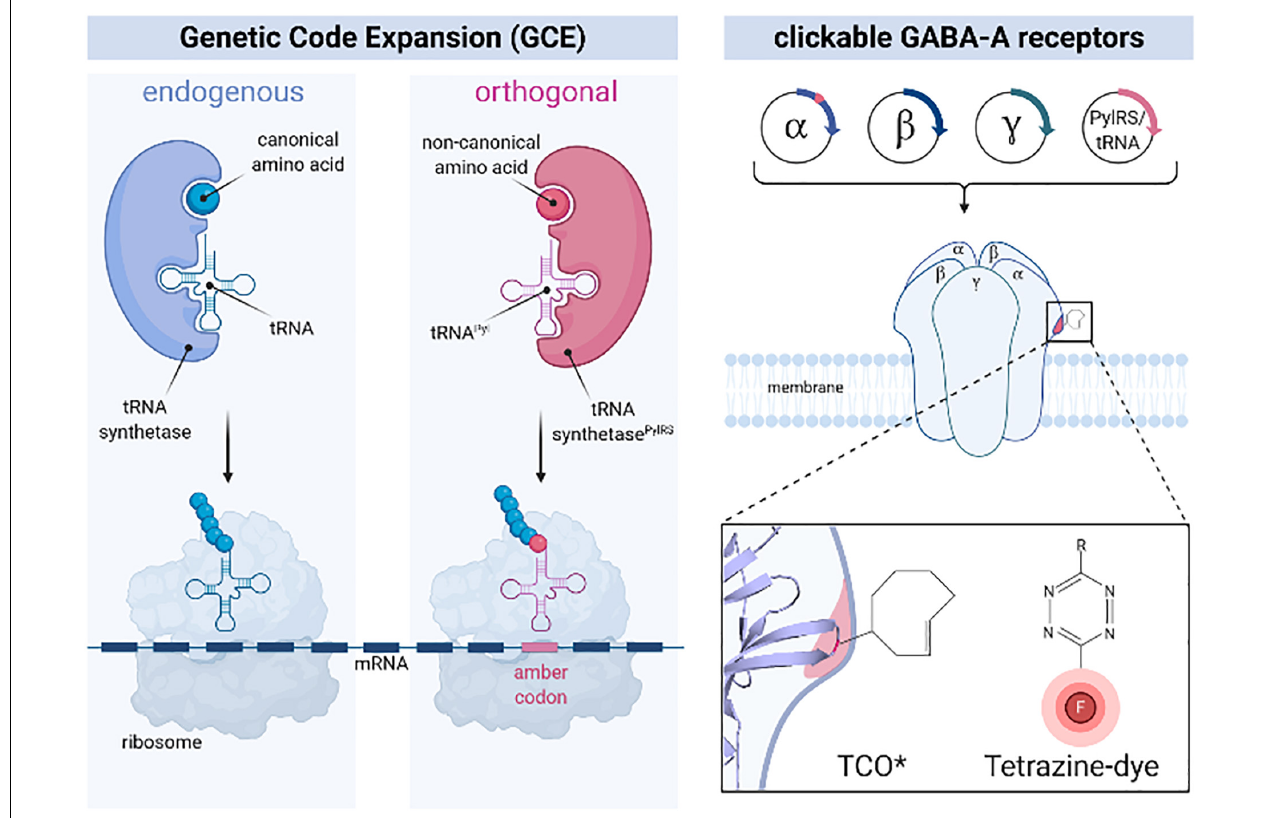
FIGURE 1 | Principle of genetic code expansion (GCE) using amber codon suppression for site-directed labeling of GABA-A receptors with tetrazine-dyes. Introduction of an orthogonal tRNA-synthetase/tRNA pair (red) to the endogenous expression machinery (blue) of mammalian cells allows site-specific incorporation of ncAA in α 2 subunits of GABA-A receptors during translation, resulting in full-length GABA-A receptors equipped with a clickable ncAA (here: TCO*) (left). The mutation site is located in the extracellular domain (ATD) of GABA-A receptor α 2 subunit (right) and labeled by bioorthogonal click chemistry with a tetrazine-dye (inset) to visualize functional, pentameric GABA-A receptors with unprecedented small linkage error in primary neurons